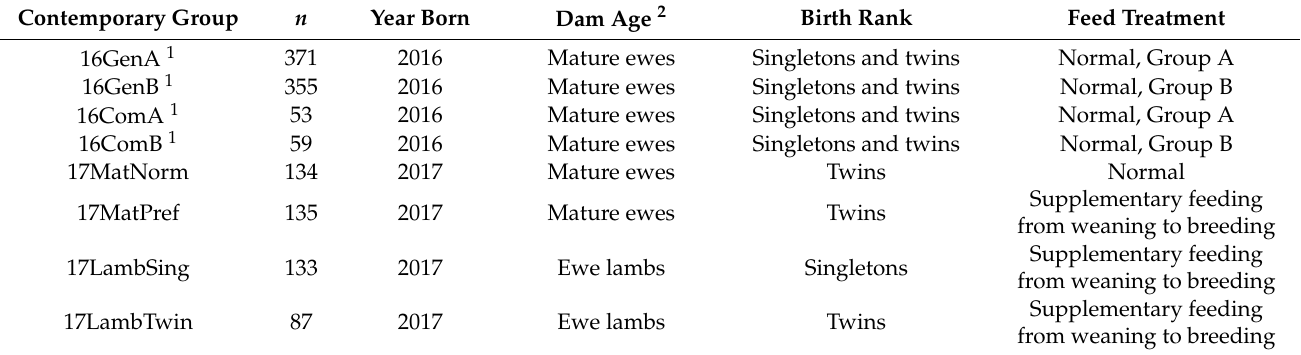
Table 1. Summary of the contemporary group effects used in the analysis of SNPs based on the year of birth, dam age group, birth rank, feed treatment and group. The n values presented were total numbers used in the analysis, with both phenotype and genotype